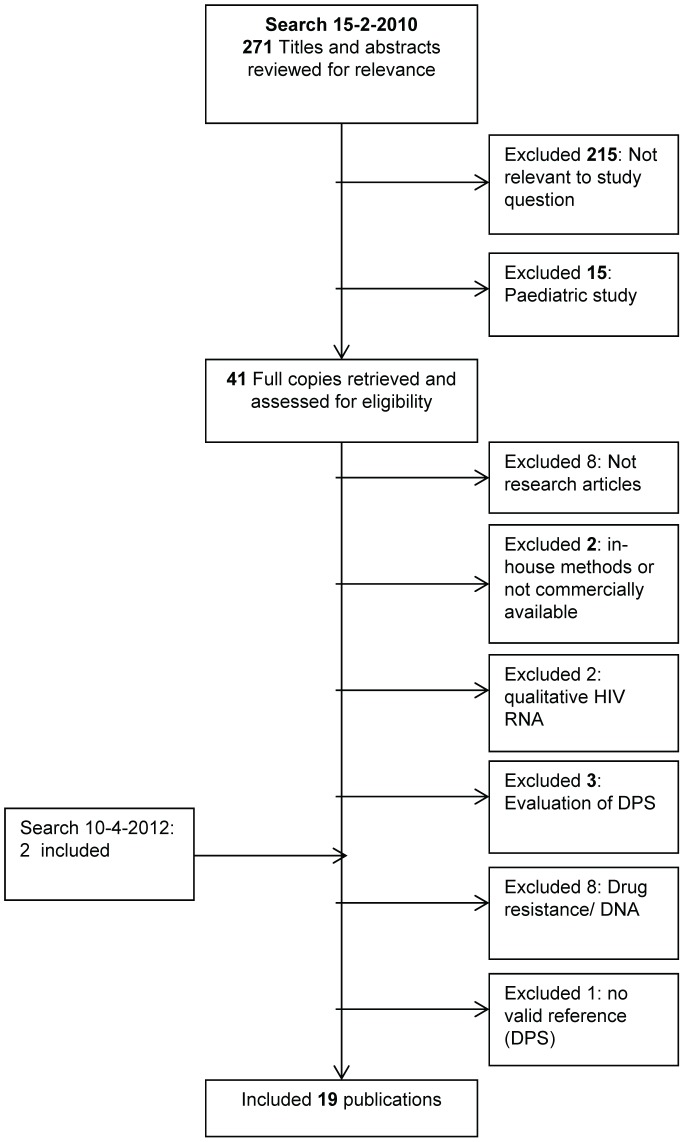
Search algorithm.